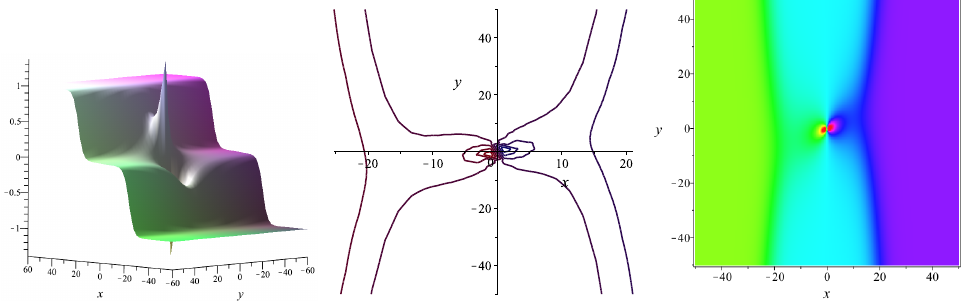
Figure 4. 3D plot, contour plot and density plot corresponding to f 6 ( x , y , z , t ) at times t =